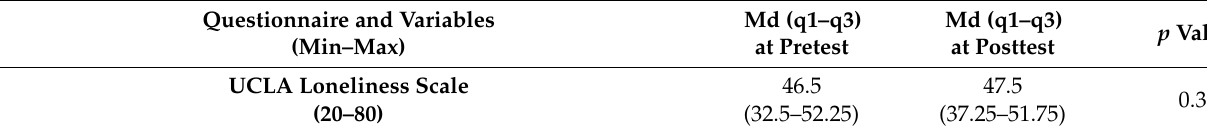
Table 3. Experienced loneliness and social network at pretest and posttest a ( n =